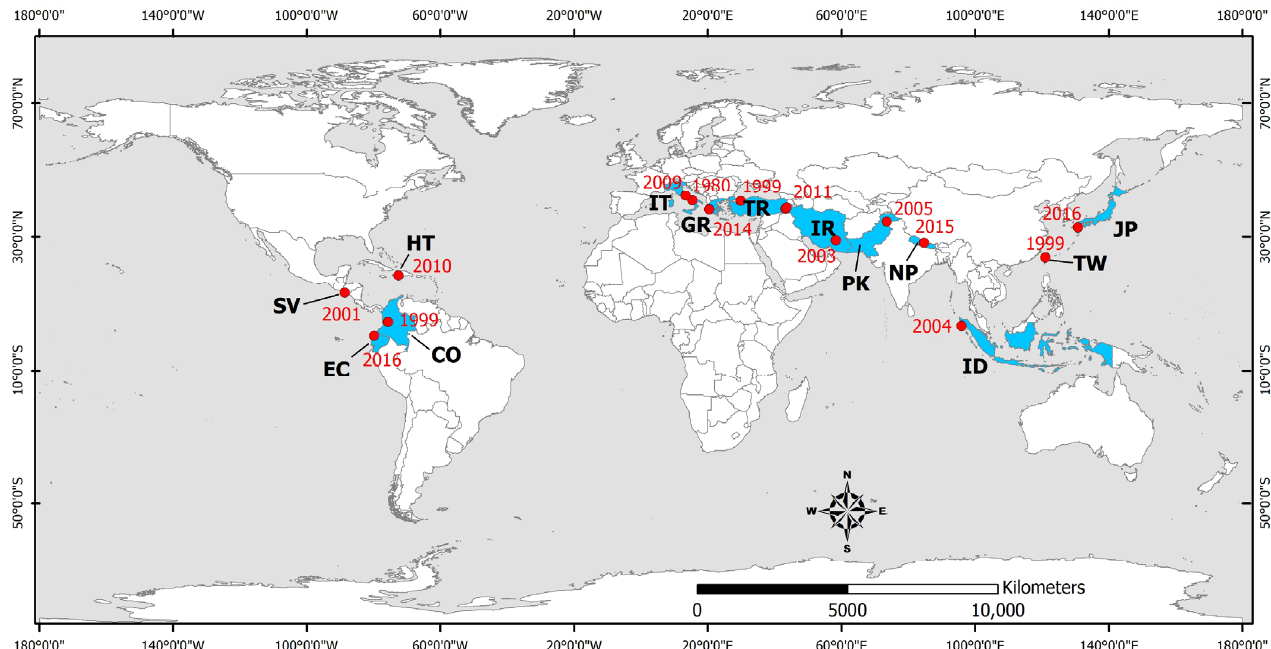
Figure 3. Countries affected by earthquake-triggered gastrointestinal infections. HT: Haiti, SV: El Salvador, EC: Ecuador, CO: Colombia, IT: Italy, GR: Greece, TR: Turkey, IR: Iran, PK: Pakistan, NP: Nepal, JP: Japan, TW: Taiwan, ID: Indonesia. The epicenters of the studied earthquakes are also illustrated (red dots) along with the occurrence year (red numbers). Table 3. Water- and food-borne infectious diseases transmitted during the post-earthquake period in earthquake-affected areas.